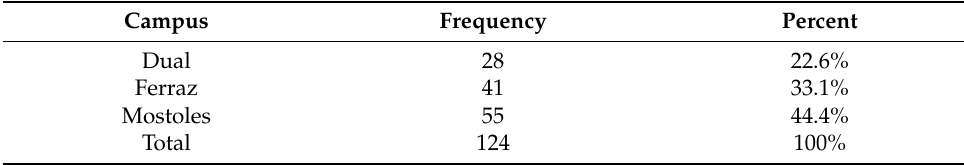
Table 3. Frequency table to second